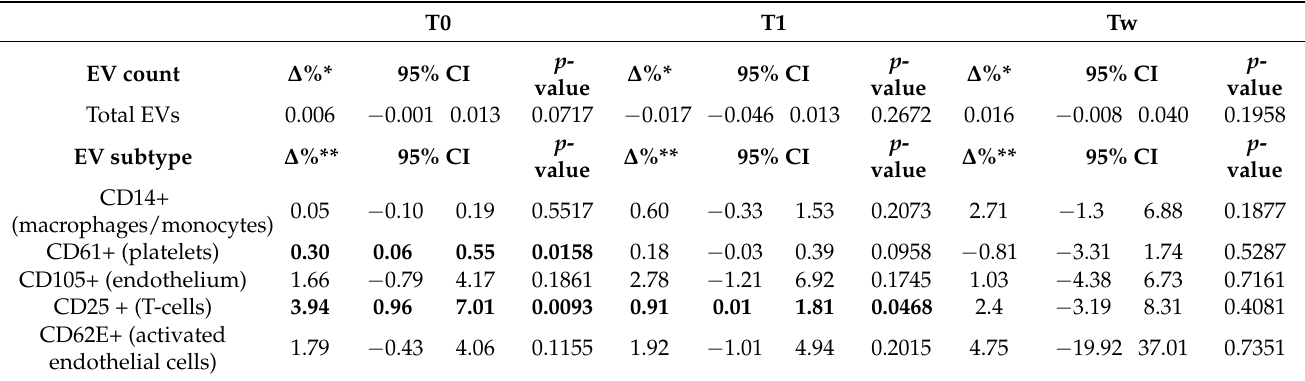
Table 4. Relationships between the modified Rankin Scale (mRS) evaluated 3 months after the acute event and count of EV and EV subtype at T0, T1, and Tw. T0 T1